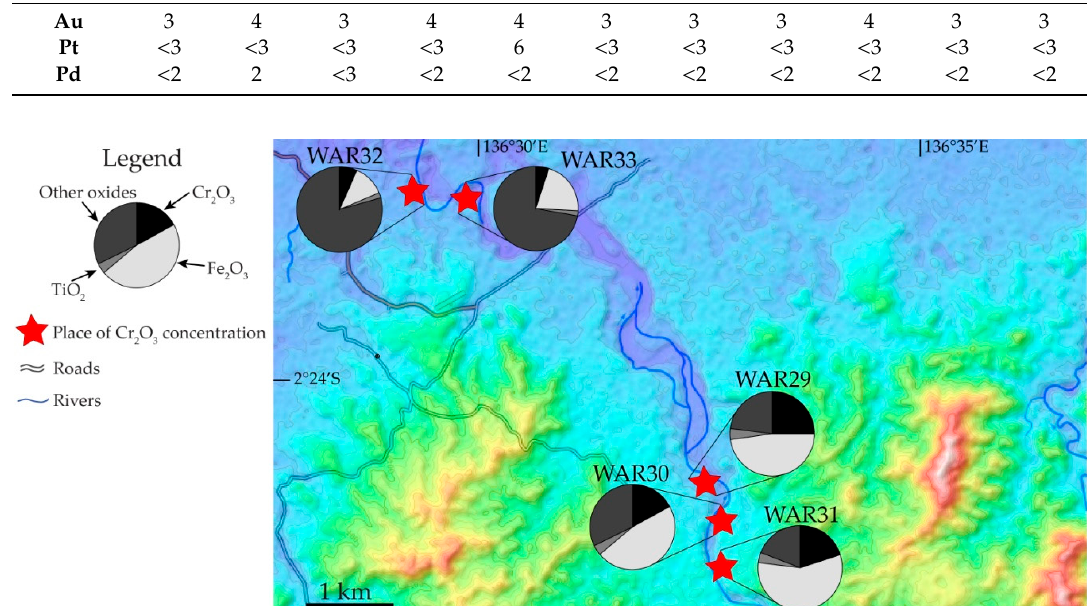
Figure 6. The concentration of oxides Cr 2 O 3 , TiO 2 and FeO 2 in samples. Sample location in the upper Botawa River is shown in Figure 2.